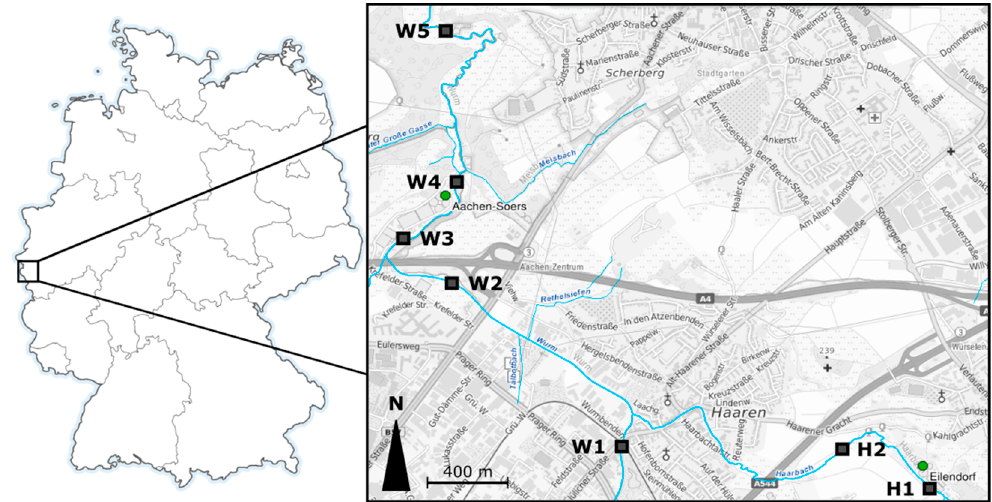
Figure 1. Study area with sampling sites along the River Wurm (W1–W5) and the River Haarbach (H1 and H2). © Data source ELWAS-WEB 2019, dl-de/by-2-0 (www.govdata.de/dl-de/by-2-0) https://www.elwasweb.nrw.de.